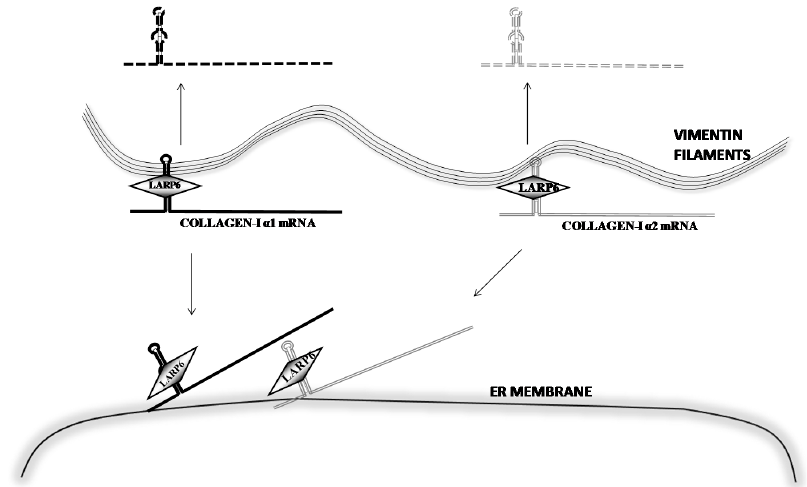
Figure 2. Stabilization of collagen mRNAs on vimentin filaments. Pools of collagen mRNAs on vimentin filaments can be activated for translation or subjected to degradation.